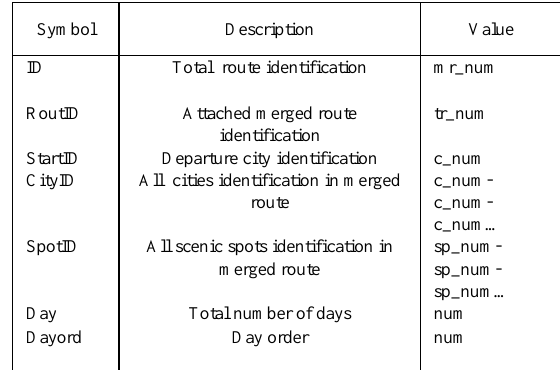
Table 3. Merged route